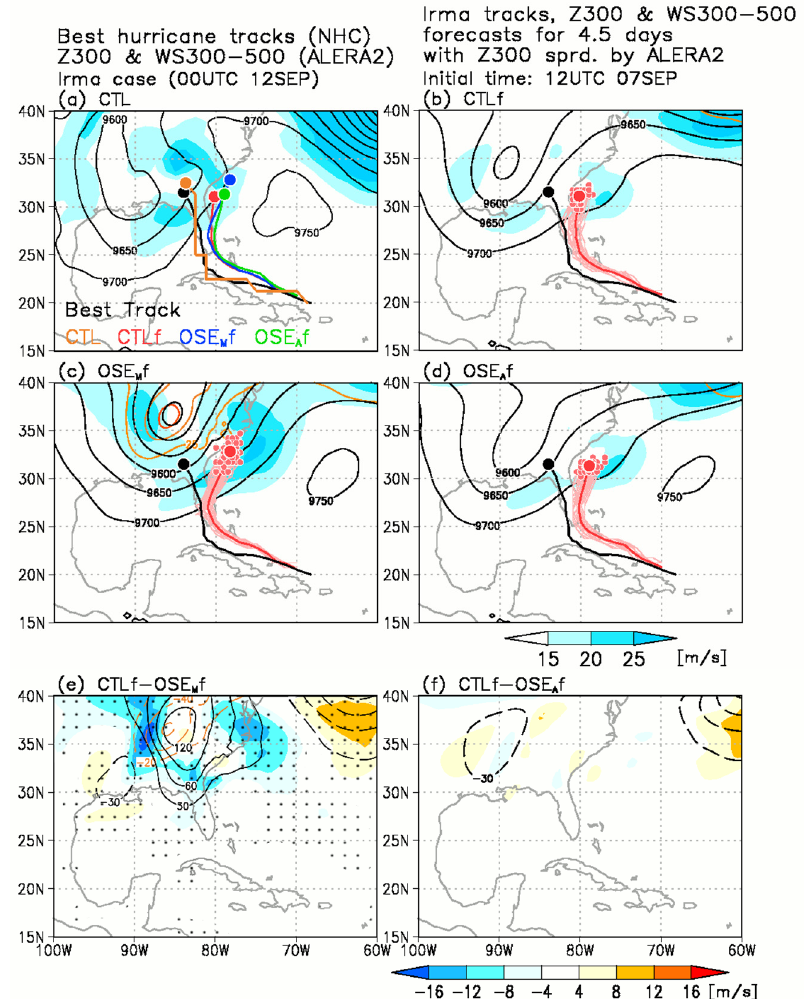
Figure 4. ( a ) Upper-level wind speed (averaged between 300- and 500-hPa levels; shaded; unit: m · s − 1 ) and geopotential height at 300 hPa (Z300; contour; unit: m) at 0000 UTC 12 September 2017 in CTL; lines are tracks of Irma between 1200 UTC 7 September 2017 and 0000 UTC 12 September 2017 from National Hurricane Center (NHC) best track data (black) and the PREPBUFR global observation datasets (CTL; orange), and predicted ensemble mean tracks from the forecast using the CTL dataset (CTLf; red), forecast using the CTL dataset with radiosonde observations from RV Mirai removed (OSE M f; blue) and forecast using the CTL dataset with dropsonde observations from aircrafts removed (OSE A f; green). ( b – d ) Predicted ensemble mean upper-level wind speed (averaged between 300- and 500-hPa levels; shaded; unit: m · s − 1 ), Z300 (black contour; unit: m), Z300 ensemble spread (orange contour; unit: m), and predicted tracks of Irma between 1200 UTC 7 September 2017 and 0000 UTC 12 September 2017 with ensemble mean (thick line) and ensemble members (thin lines) from ( b ) CTLf, ( c ) OSE M f, and ( d ) OSE A f; black line is track of Irma from NHC best track data. ( e , f ) Di ff erence between forecasts in ensemble mean upper-level wind speed (averaged between 300- and 500-hPa levels; shaded; unit: m · s − 1 ), Z300 (black contour; unit: m), and Z300 ensemble spread (orange contour; unit: m); di ff erence ( e ) between CTLf and OSE M f, and ( f ) between CTLf and OSE A f; dots indicate statistical significance at the 99% confidence level.